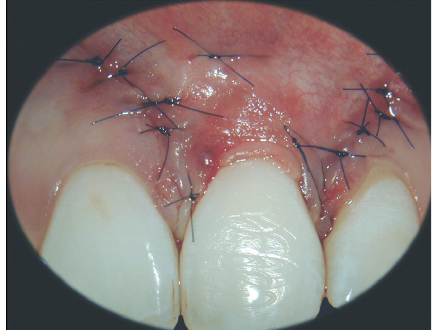
Figure 6: The flap was sutured in a more coronal position, and the connective tissue graft was partially covered.